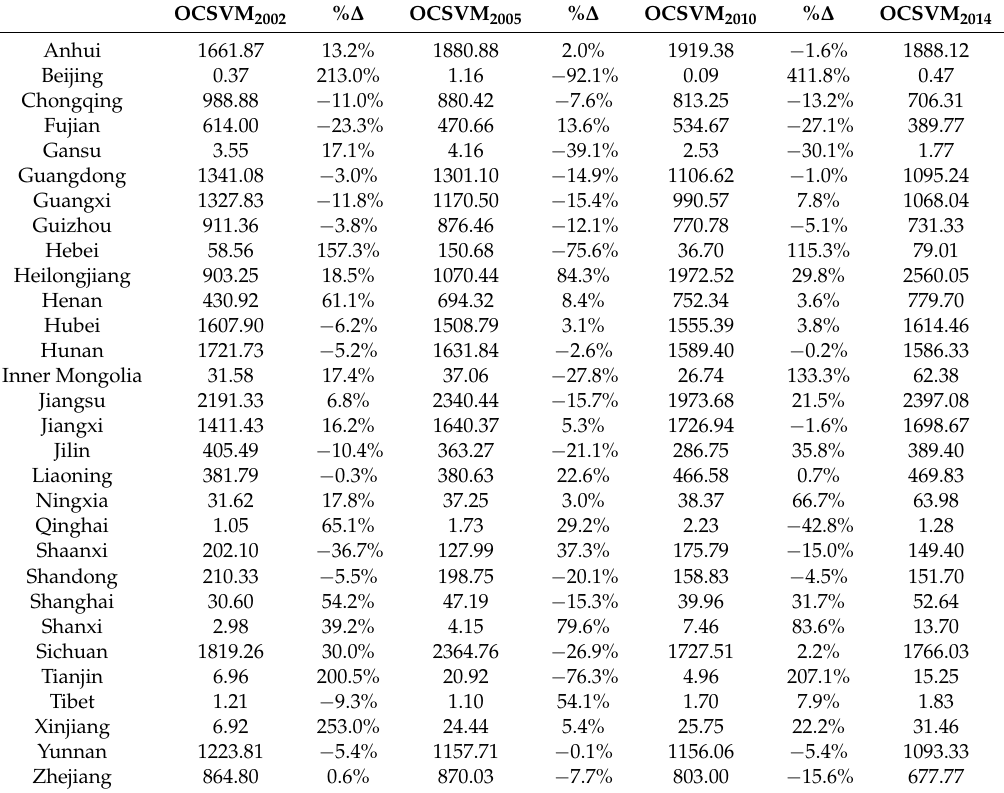
Table 3. Rice area and change per province in 1000 ha derived from our classifications.